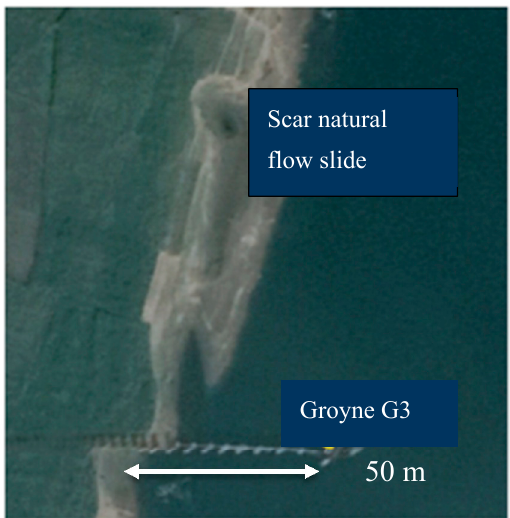
Figure 15. Example of a scar of a small flow slide or slip circle failure at the edge of a minor channel probably initiated by pushing forcefully a country boat against the bank of the groyne test structure near Kamarjani (Google Earth,